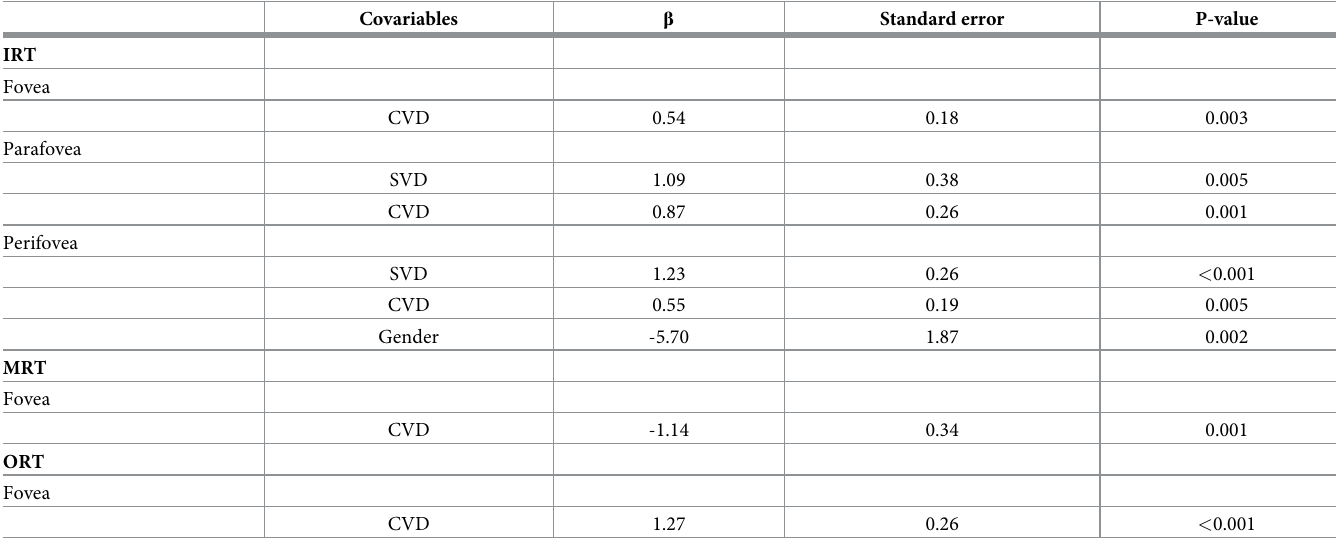
Table 3. Association of covariables with retinal thickness.